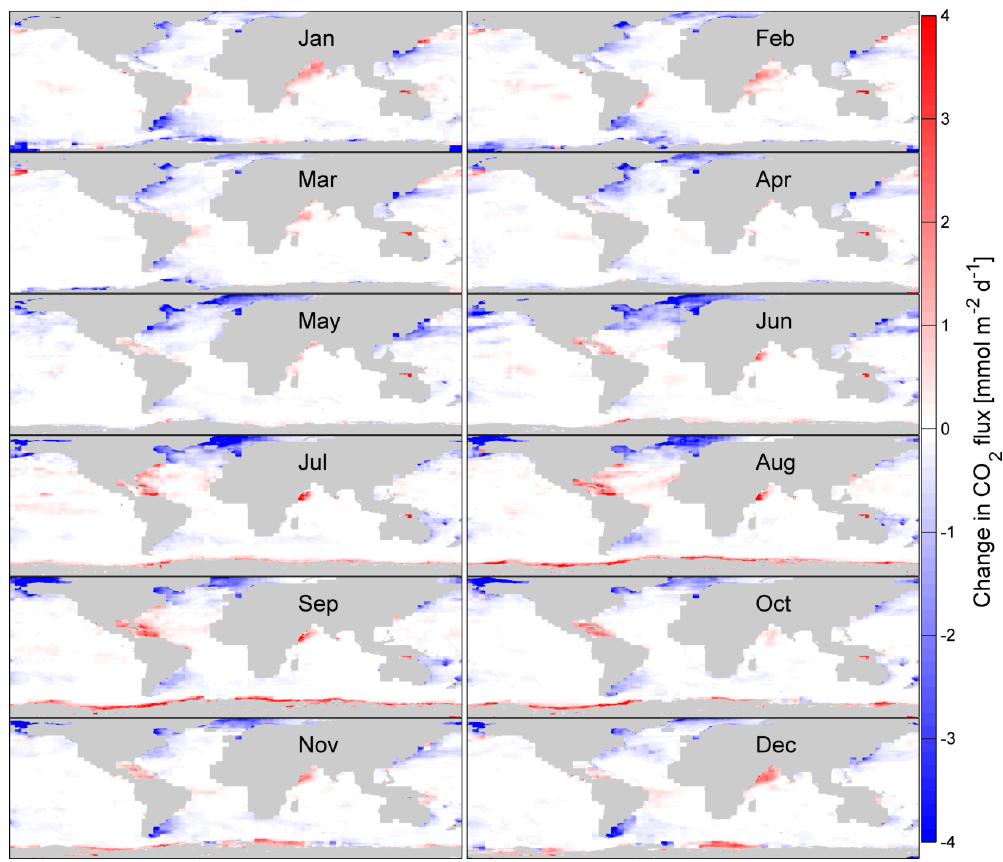
Figure 9. The absolute change of CO 2 gas transfer due to suppression for each month of 2014. Negative values (blue) denote areas where a flux into the ocean is reduced by the shown value. Positive values denote areas where flux out of the ocean is reduced by the shown value. The change is calculated using the bulk flux formula (Eq. 1) and (cid:49)k (Eq.